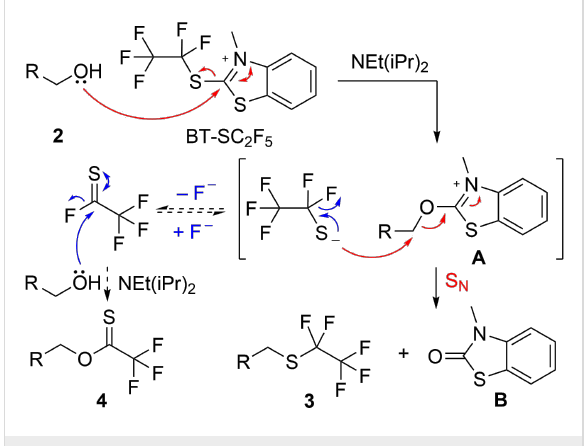
Scheme 3: Plausible mechanism for the formation of thioether 3 and thionoester 4 .